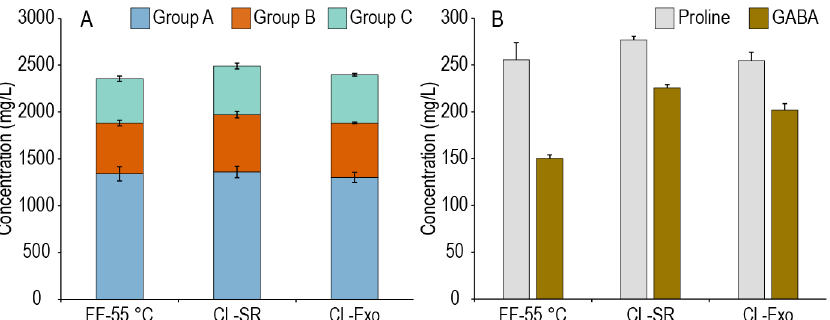
Figure 2. Sum of usable amino acids by utilization Group ( A ) and proline and GABA concentrations ( B ) of the samples collected at the end of the enzyme extraction phase of the FF-55 °C, CL-SR, and CL-Exo mashing experiments. FF-55 °C was sampled from the first batch of millet malt, while the CL samples were from the second batch of millet malt. Worts from this enzyme extraction phase are at a liquor-to-grist ratio of 3:1.